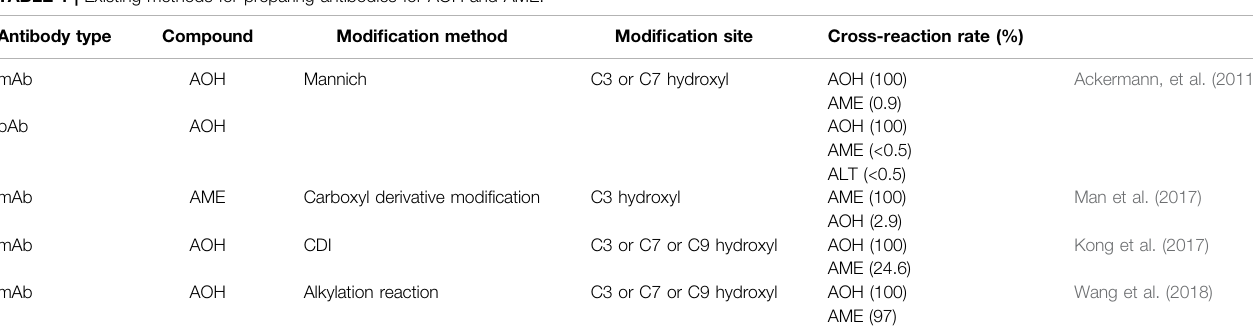
TABLE 1 | Existing methods for preparing antibodies for AOH and